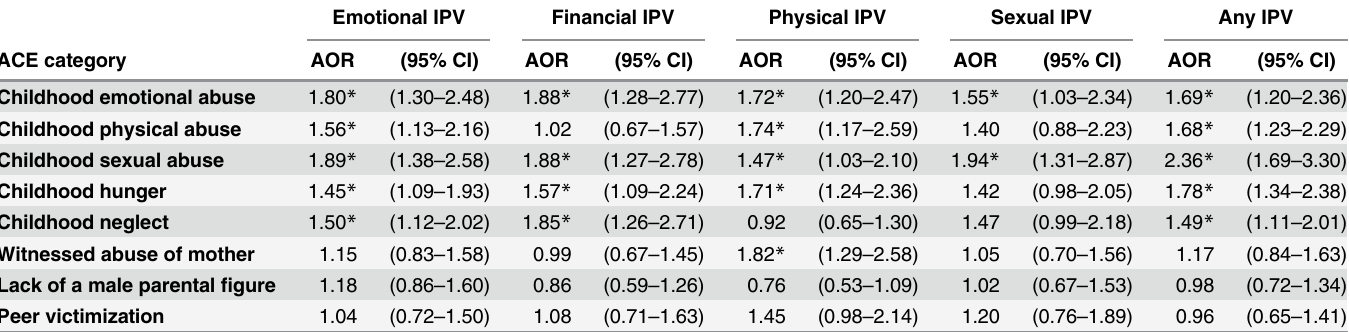
Table 7. Logistic regression analysis of the odds of intimate partner violence (IPV) perpetration with exposure to individual adverse childhood experiences (ACE) categories among ever-partnered Sri Lankan men (n = 1252), UN Multi-Country Study on Men and Violence in Asia and the Pacific, Sri Lanka, 2011 –